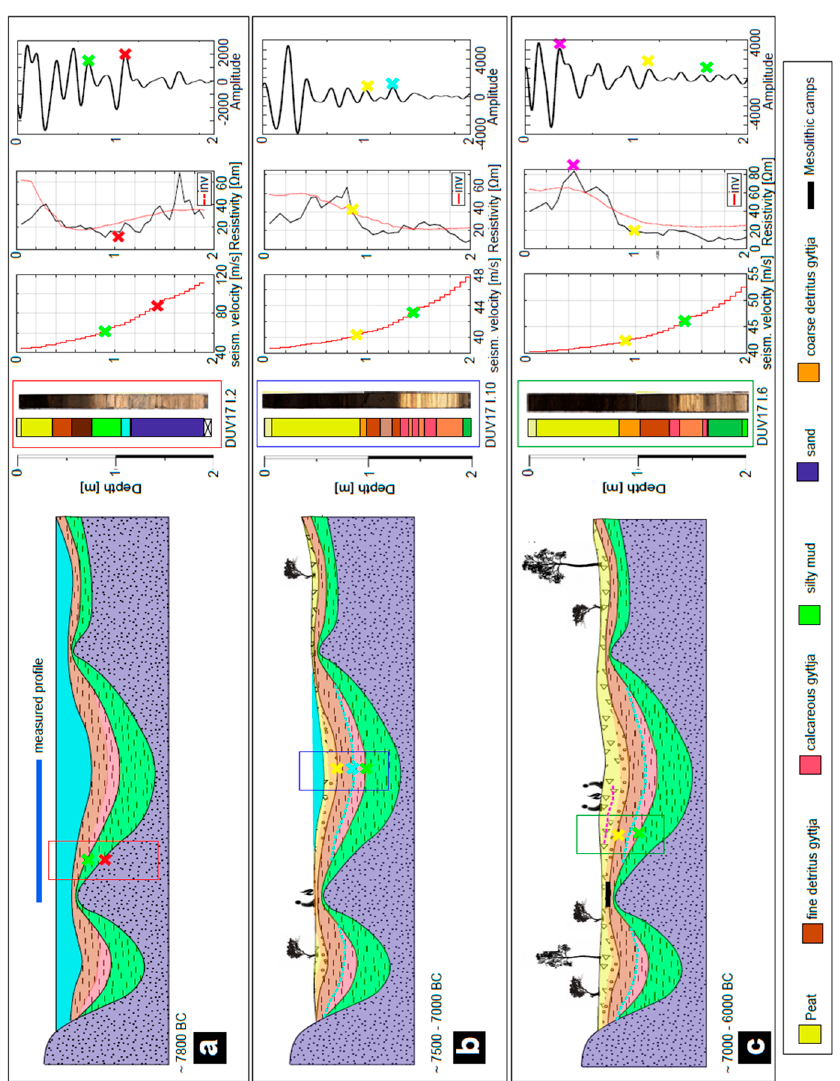
Figure 10. Interpreted model for the Duvensee Moor development from ~7800 BC ( a ) to ~7000 ( b ) and ~6000 BC ( c ) illustrating the gradual sediment deposition within the basin during the Mesolithic period (after [52,75]). The 1D traces belonging to each applied geophysical method are reported on the side and the main changes are indicated with colored crosses. The blue line indicates a suggestion for the location of the measured profile.